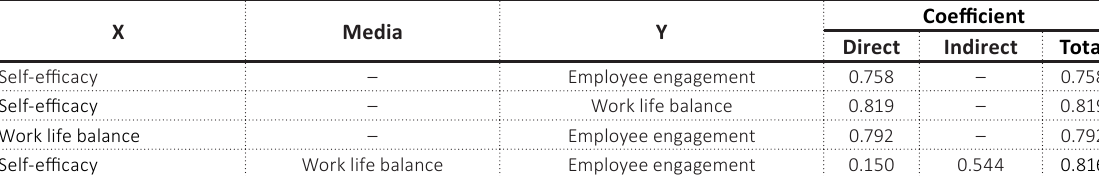
Table 4. Hypotheses analysis of direct and indirect relation